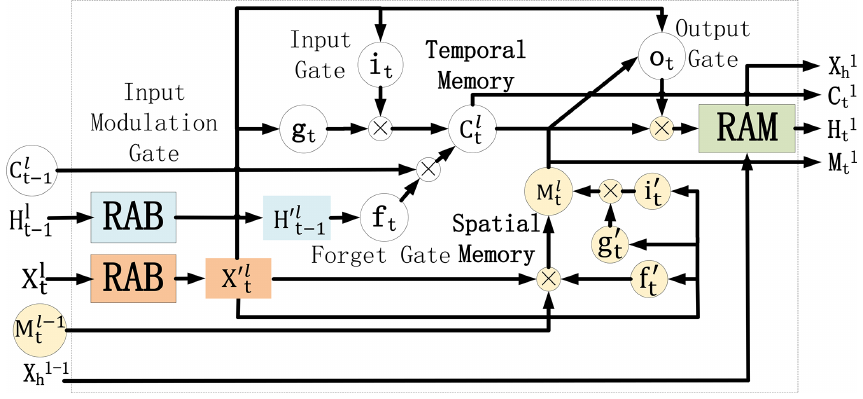
Figure 2. The internal structure of the Region Attention Predictive Unit (RAP-Unit).